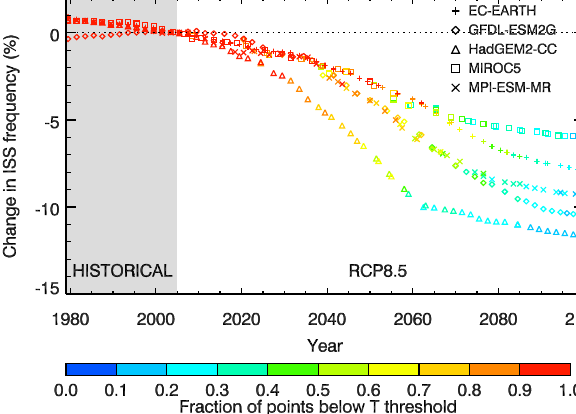
Figure 6. Time series of the change in 250hPa CISS frequency (in percentage points) in the tropics in the CMIP5 models (symbols) from 1979 to 2099, calculated for each year as the annual-mean CISS frequency minus the 1979–2005 average (the historical pe- riod, shown by grey shading). The colour of the points shows the fraction of points in the tropics which are below the 233K temper- ature threshold for CISS. A 10-year running mean has been applied to each time series before